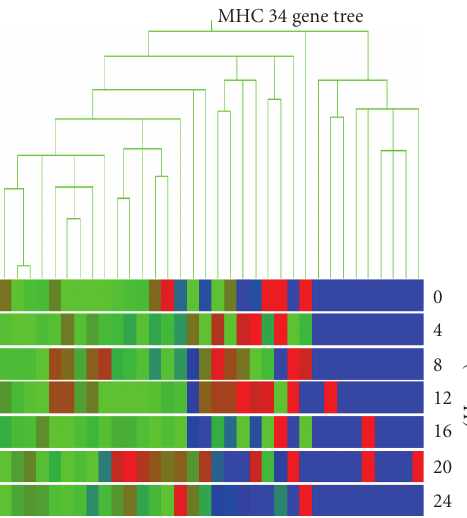
Figure 7: Gene tree of MHC genes fluctuated during C. neoformans infection: expression profiles changes in HBMEC are observed. A subgroup of the profile with MHC class genes was selected and sub- jected to Gene Tree analysis using GeneSpring TM software. The al- ternations of gene expression in this group suggested that innate immune contributes to C. neoformans